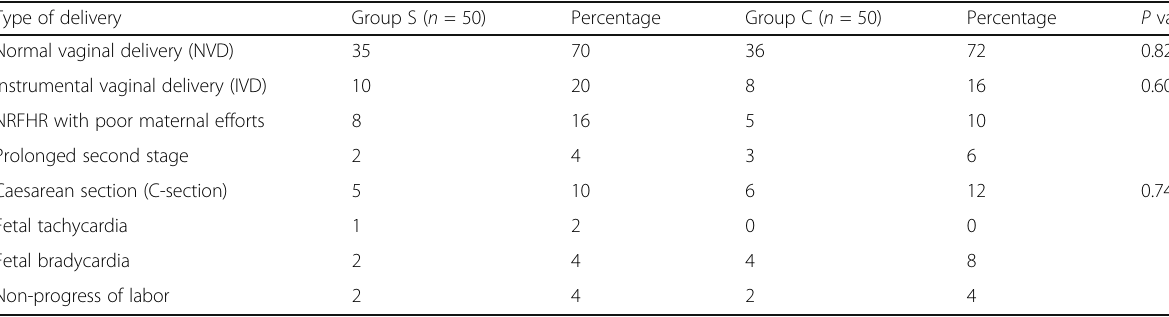
Table 3 Comparison of type of delivery in two groups Type of